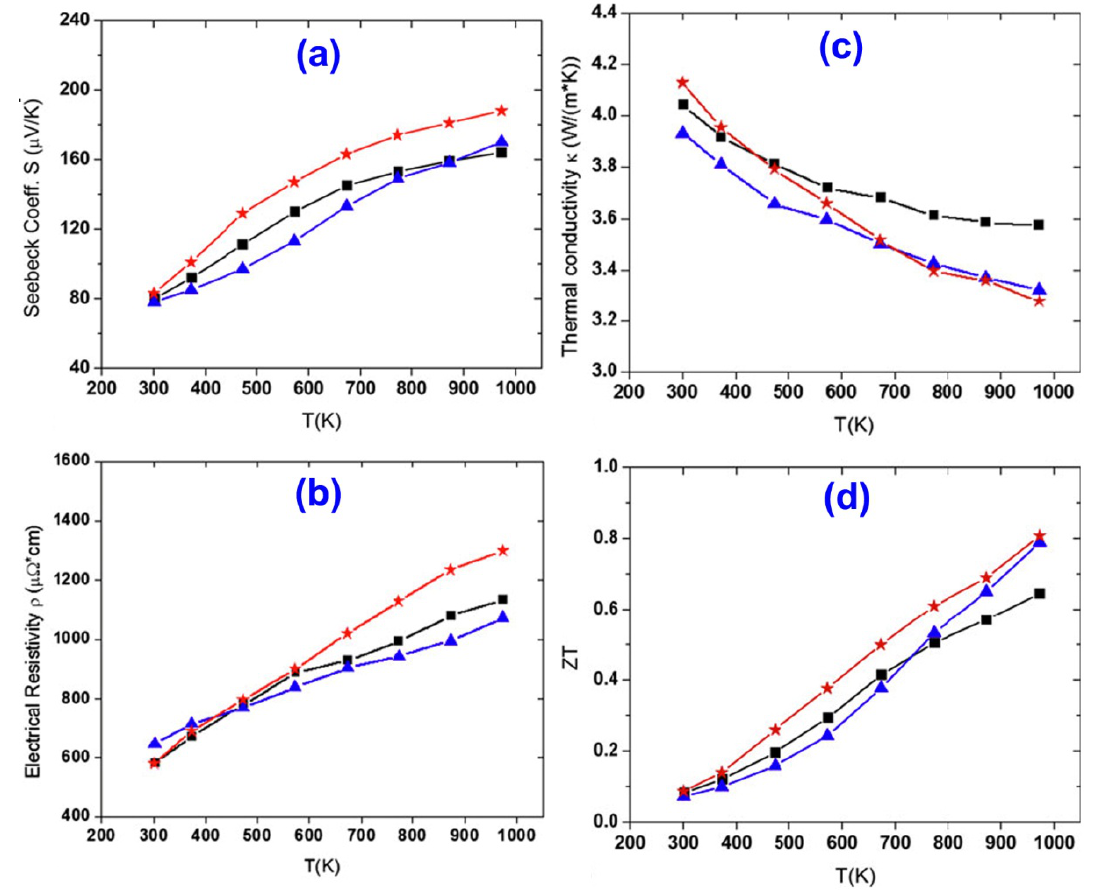
Figure 9. TE transport properties of 0% (square), 1% (triangle), and 2% (star) ZrO nanoparticles dispersed p -type Hf ( b ) electrical resistivity; ( c ) thermal conductivity; and ( d ) ZT values. Reproduced with permission from Ref. [110]. Copyright 2011, Cambridge University